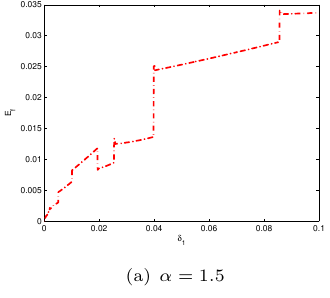
Figure 3. The variation of E f with δ 1 (Example